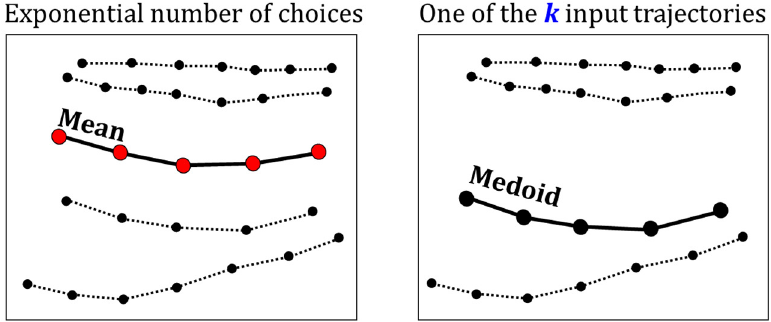
Figure 3. Examples of using mean ( left ) and medoid ( right ) for segment averaging.